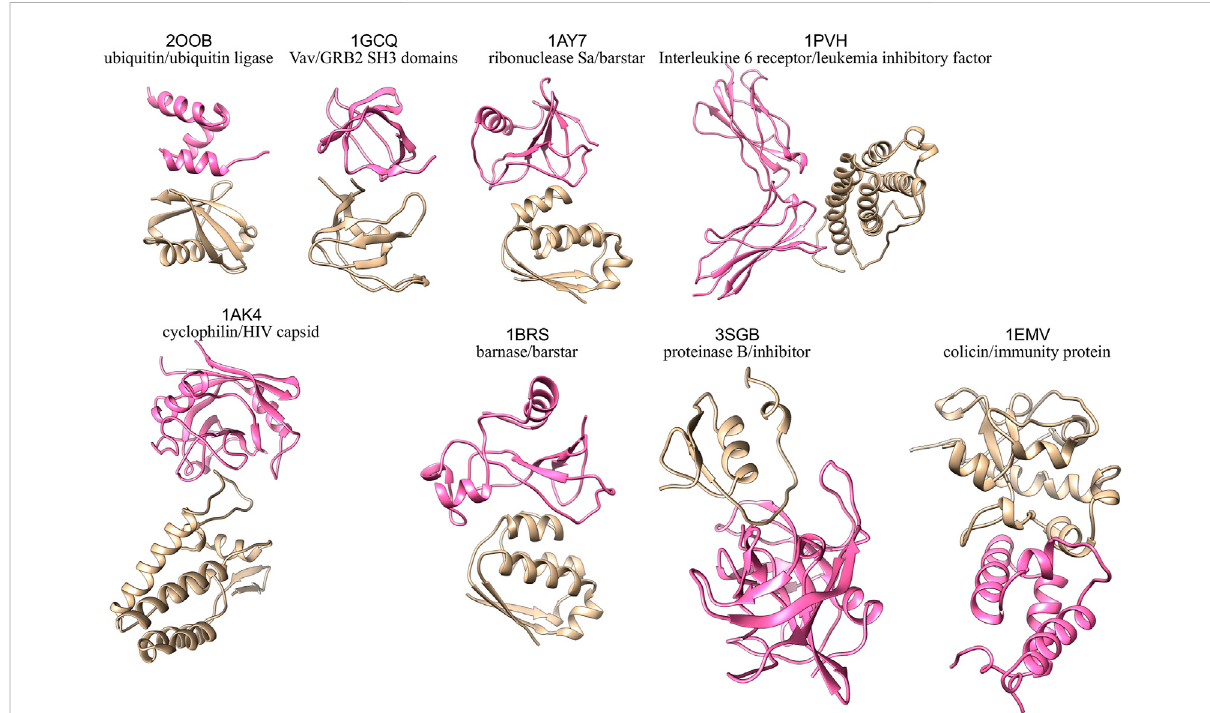
3D structures of the eight protein-protein complexes simulated in this study, with one partner colored in pink and the other one in